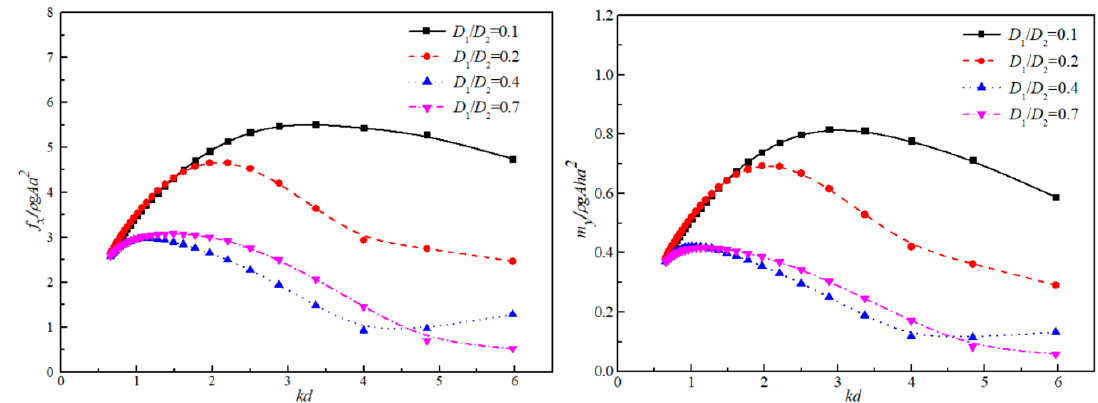
Figure 10. Distribution of wave force and wave moment on the outer cylinder with different D 1 / D 2 .